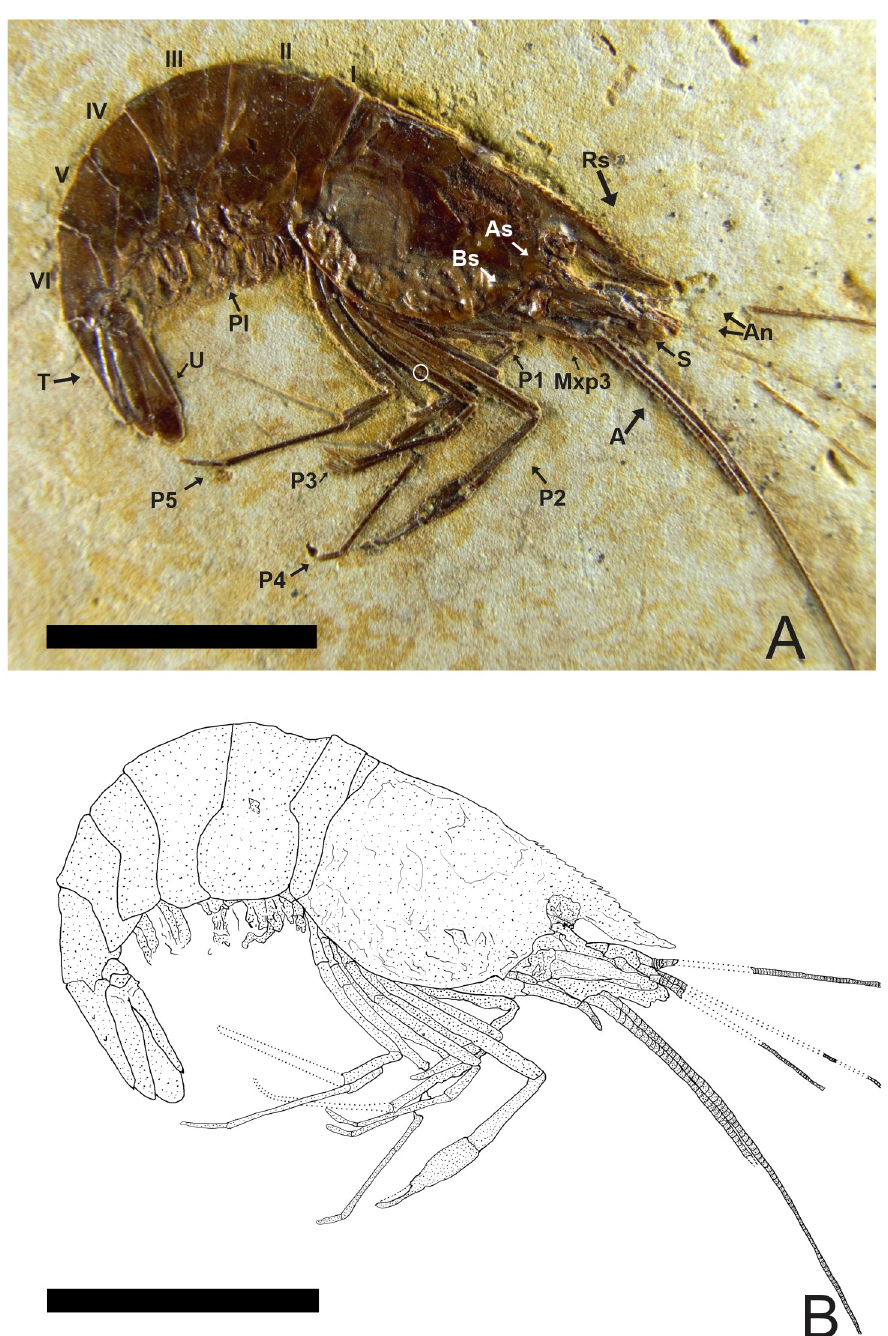
Fig 8. 2108/MPSC (URCA). (A) Lateral view of the 2108/MPSC (URCA). (B) Reconstitution, dotted lines represent appendages not preserved but with impressions on the matrix. Rs: Rostrum; An: Antennule; A: Antenna; As: Antennal spines; Bs: Branchiostegal spines; S: Scaphocerite; Mxp3: Third maxilliped; P1-P5: Pereiopods; Pl: Pleopods; I-VI: Pleon; T: Telson; U: Uropods. Scale bars: 10 mm. Photo and drawing by Olga A. Barros.